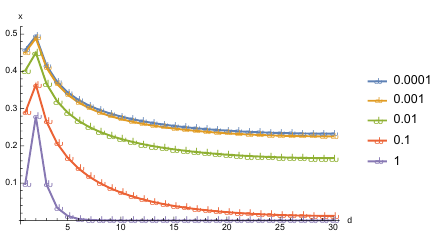
Figure 7 . The plots of the optimized values of the parameter x which give the minimum of S in the setup of j A j = j B j = 1. In this graph, from the above to the bottom, the mass varies m = 0 : 0001 ; 0 : 001 ; 0 : 01 ; 0 : 1 ; 1.